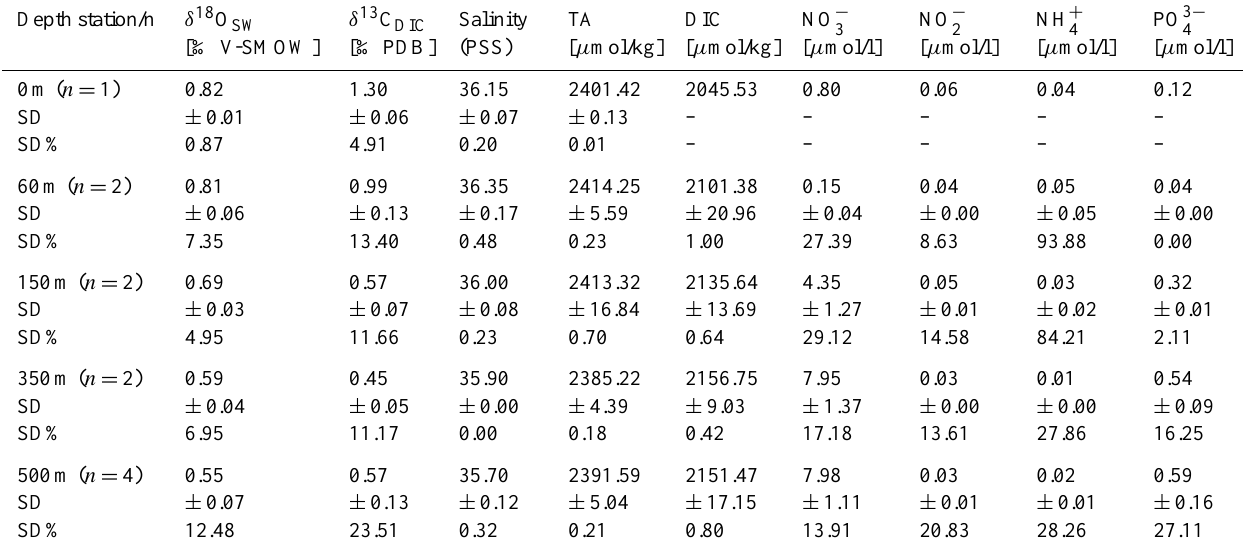
Table 2. Summary of measured water property data, as there are the stable isotope signature, salinity, total alkalinity, total dissolved inorganic ) , nitrite (NO − ) , ammonium (NH + ) and phosphate (PO 3 − ) . Mean values are given per depth station together with the carbon, nitrate (NO − 3 2 4 4 absolute and percentaged standard